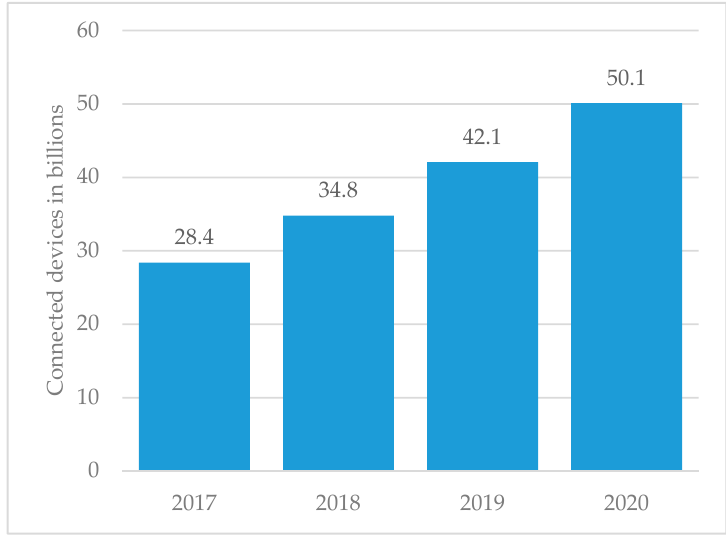
Figure 1. Internet of Things (IoT): Number of connected devices worldwide [8].